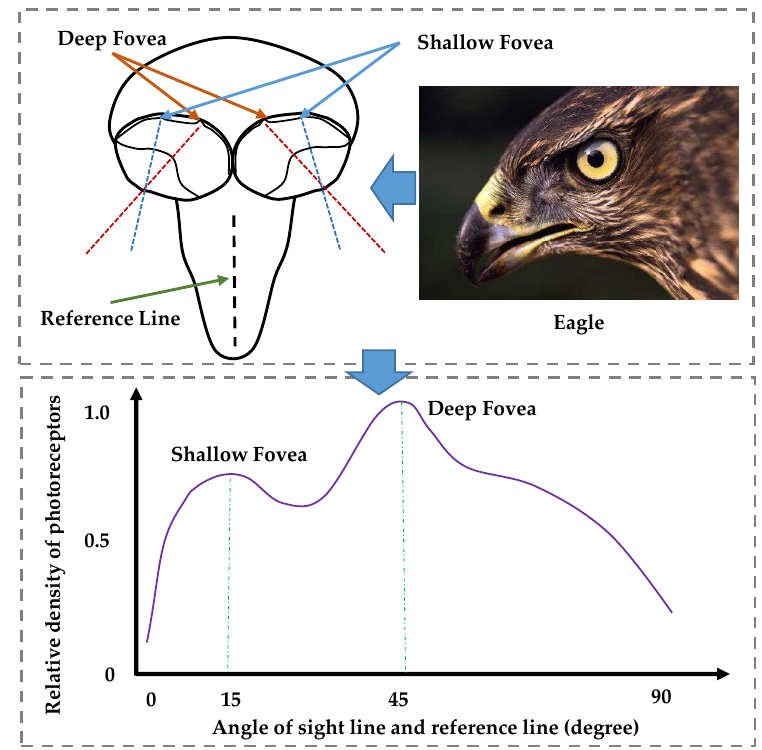
Figure 1. The structure of eagle eye with two foveae [62].